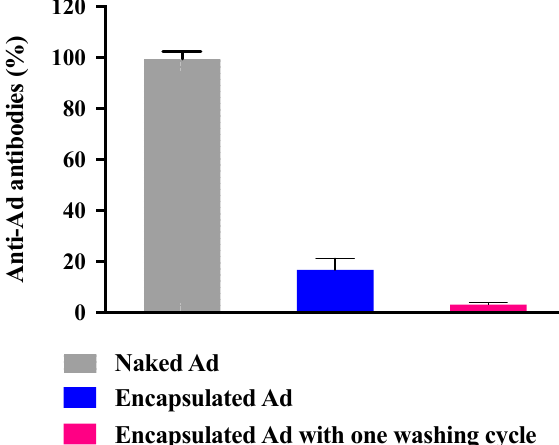
Figure 10. Hexon ad-specific ELISA antibodies. Antibodies were inoculated in vitro with encapsulated Figure 10. Hexon ad ‐ specific ELISA antibodies. Antibodies were inoculated in vitro with Ad and naked Ad. Experiments were conducted in triplicate ( n = encapsulated Ad and naked Ad. Experiments were conducted in triplicate ( n = 3).